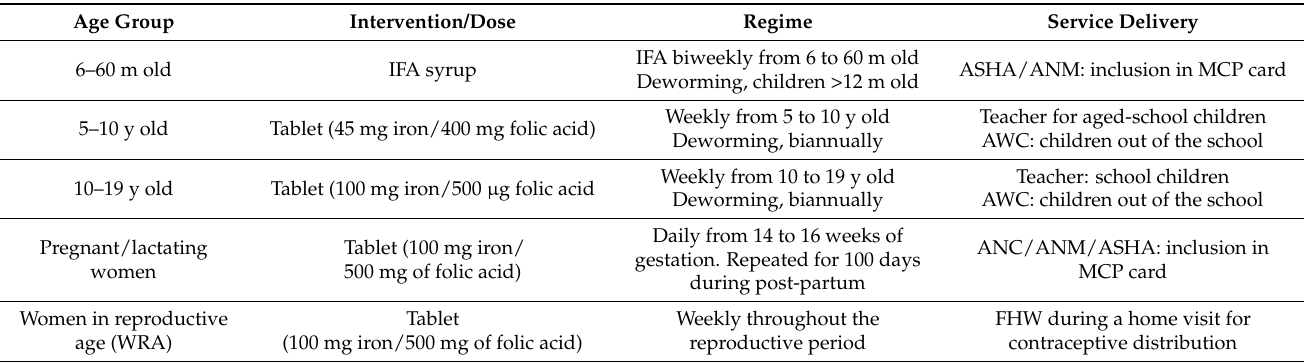
Table 4. NIPI intervention and regime. IFA-syrup supplement of iron and folic acid (1 mL containing 20 mg iron/100 mg folic acid). The Mother and Child Protection card (MCP) is an entitlement card and counselling and family empowerment tool, which would ensure tracking of the mother and child cohort for health, nutrition, and development purpose; the MCP card has the potential to create awareness, facilitate community dialogue and generate demand for uptake of vital services being provided as the first contact point between a pregnant woman and the health system. The MCP card is maintained by ASHA and Auxiliary Nurse Midwifery